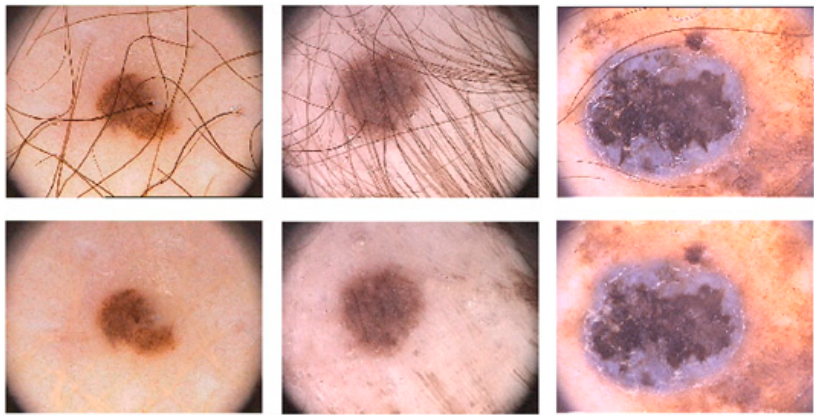
Figure 5. Hair removal results in skin lesion images by using the DullRazor algorithm.